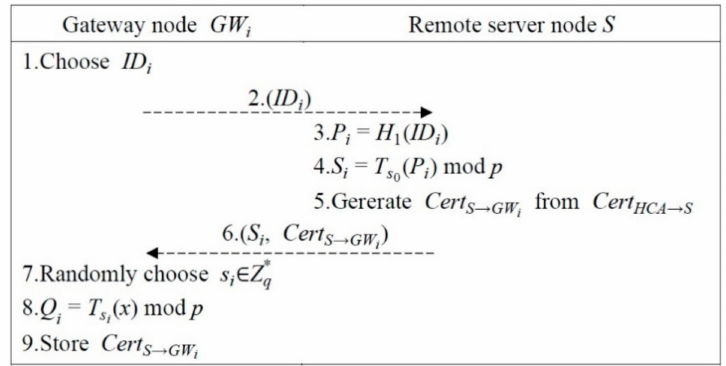
Figure 3. Gateway node registration phase of proposed scheme.